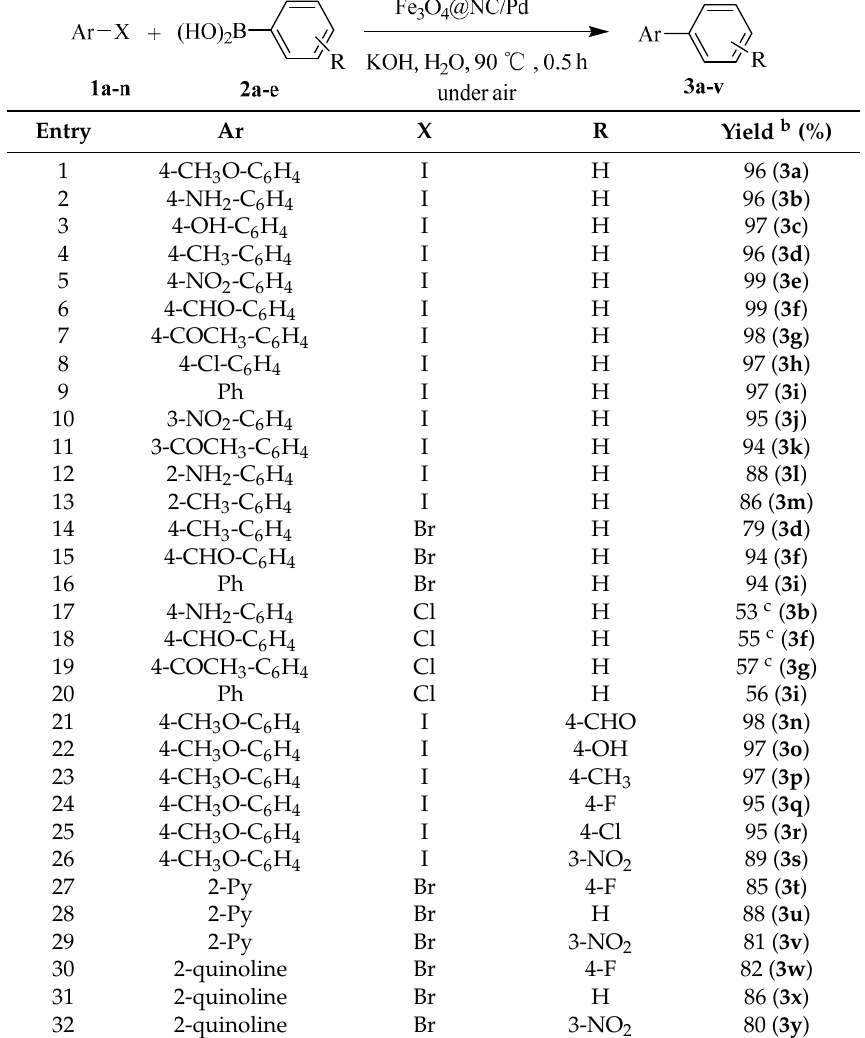
Table 2. Suzuki coupling between aryl halides and arylboronic acids in the presence of Fe 3 O 4 @NC/Pd . a.